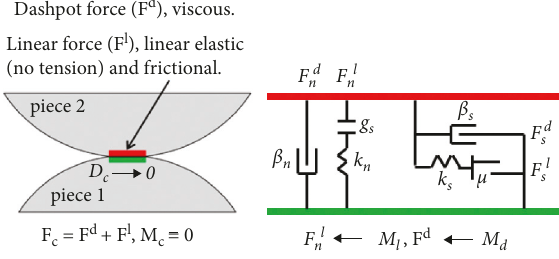
Figure 3: Schematic diagram of linear contact